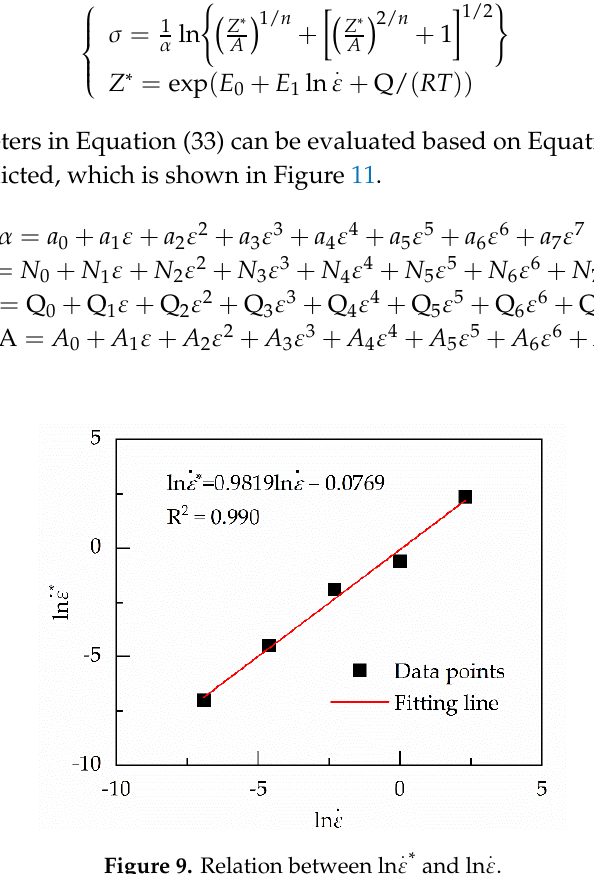
Figure 9. Relation between ln 𝜀̇ ∗ and ln 𝜀̇ .